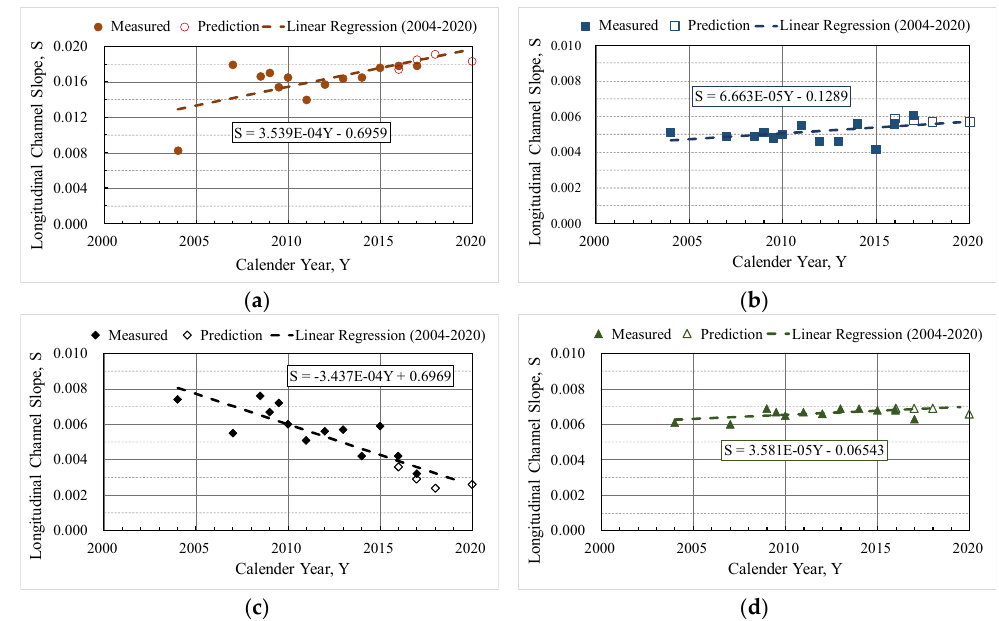
Figure 10. Measured and predicted longitudinal channel slopes for the four sub-reaches with medium-scale: ( a ) The head-cutting sub-reach: XS117-XS115; ( b ) the soft bedrock sub-reach: XS115-XS108; ( c ) the transition sub-reach: XS108-XS105; and ( d ) the alluvial sub-reach: XS105-XS90.